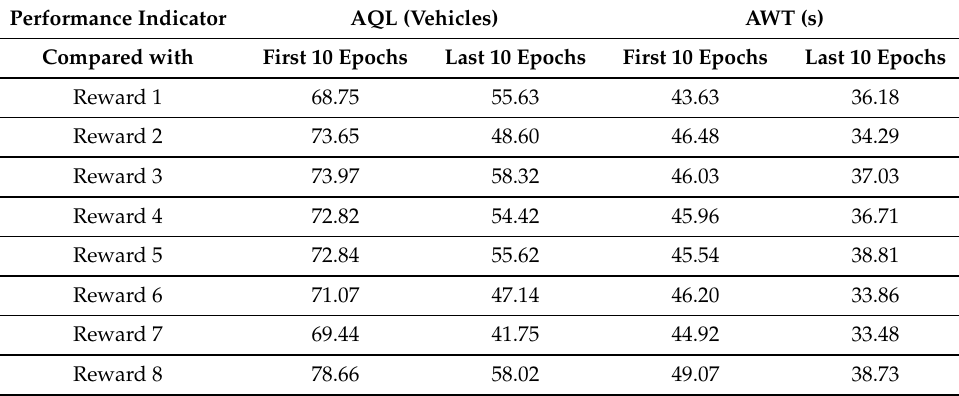
Table 4. Comparison of training results among 8 reward functions for AQL and AWT. Performance